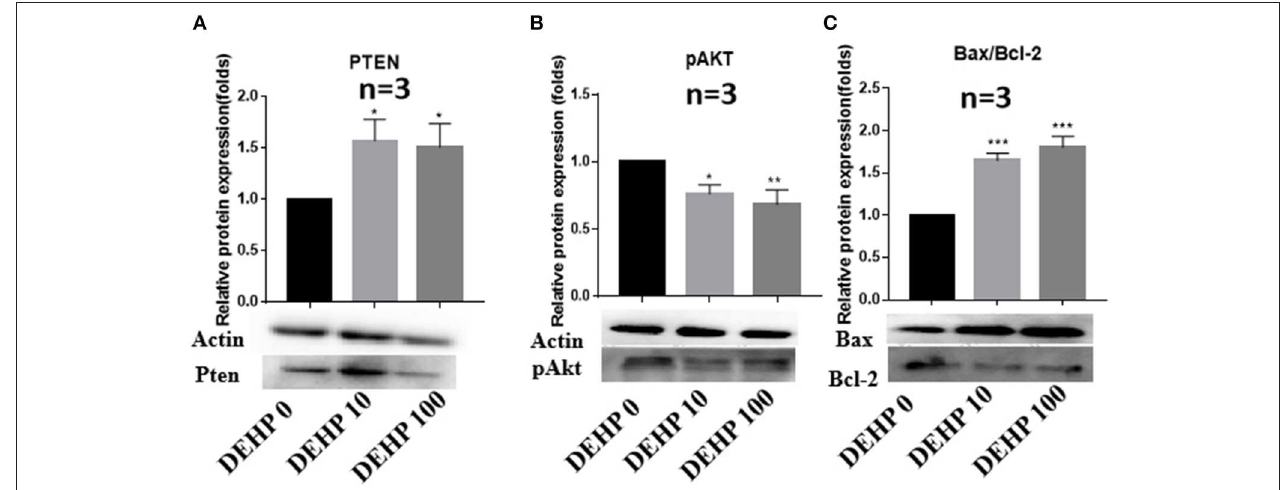
FIGURE 6 | Verification of protein expression by western blot. (A) Western blot and the gray intensity of PTEN, (B) western blot and the gray intensity of pAKT, (C) western blot and the gray intensity of Bax and Bcl-2. The results are presented as mean ± SD of at least three independent experiments. * P < 0.05, ** P < 0.01, *** P < 0.001.